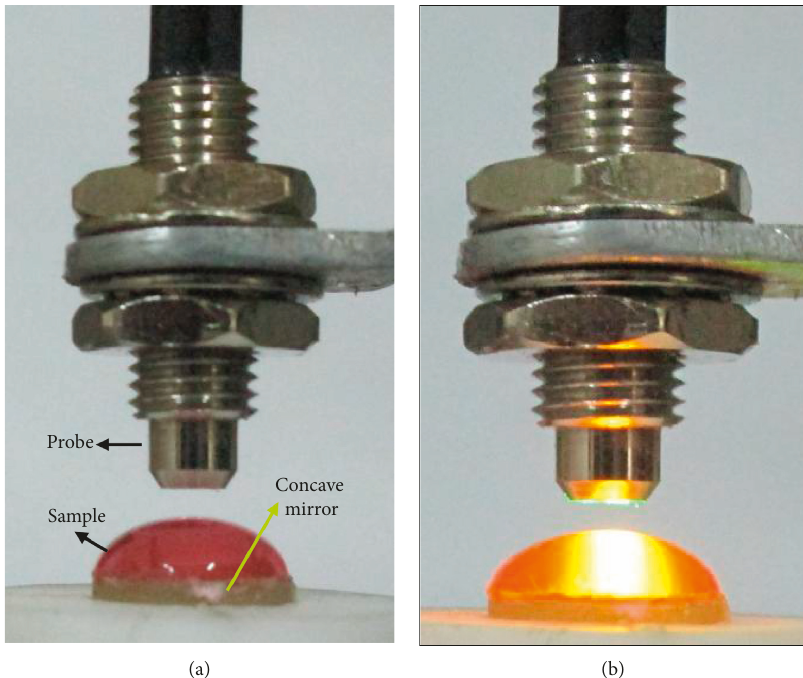
Figure 3: Photograph of the sample in the container (concave mirror) when (a) no laser light and (b) illuminated by laser light.